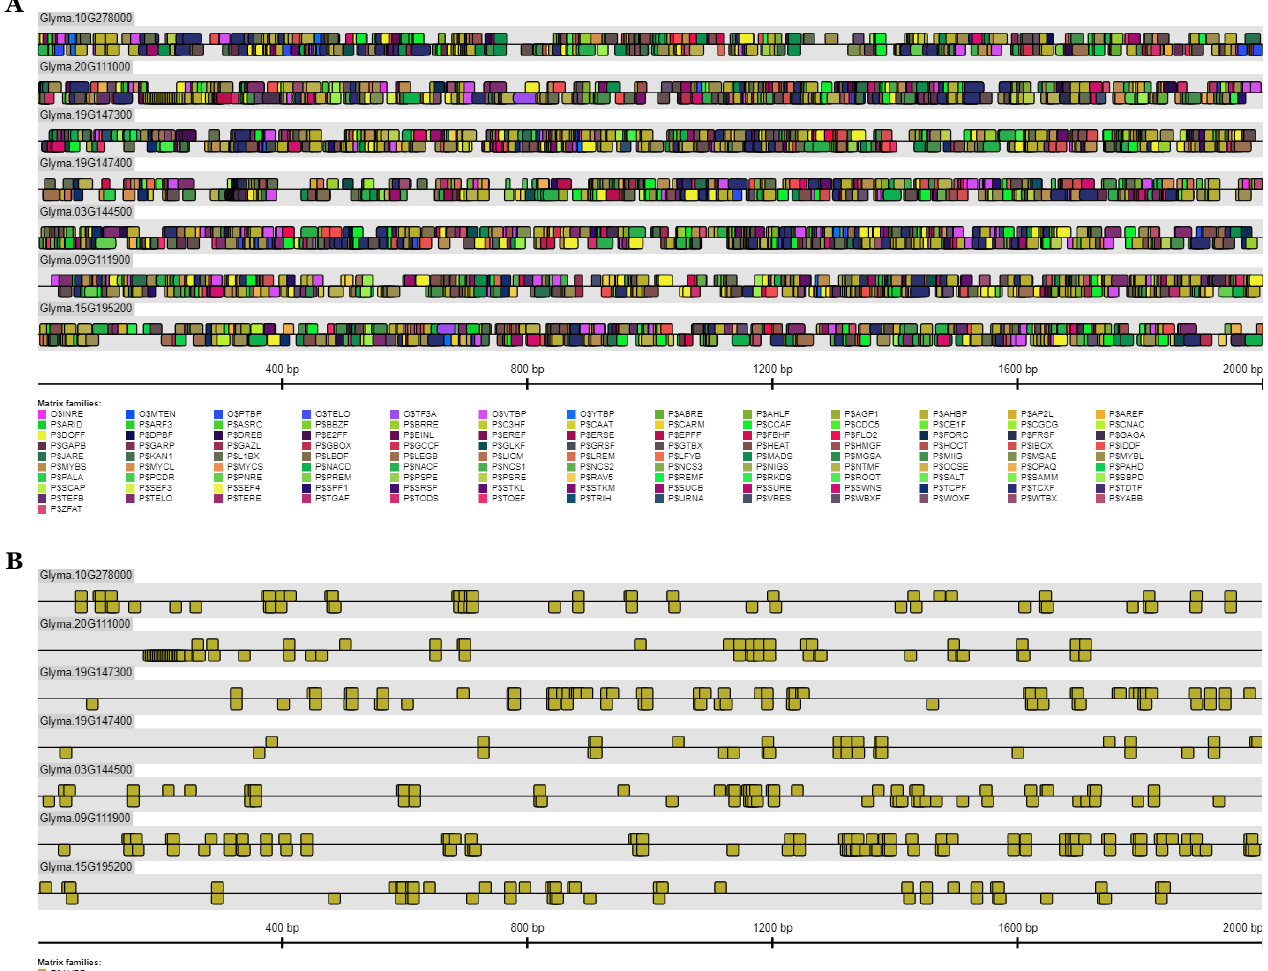
Figure 5. Analysis of putative cis -elements in the promoter region of the GmFAD2-1 and GmFAD2-2 gene members. ( A ) All identified cis -elements at the GmFAD2-1 and GmFAD2-2 promoter region ( − 2 Kb upstream). ( B ) Shows the conserved Arabidopsis homeobox protein domain (P$AHBP) that was shared between all GmFAD2-1 and GmFAD2-2 subfamily members with a total match that was significantly higher (459) when compared to the other cis -elements shown in ( A